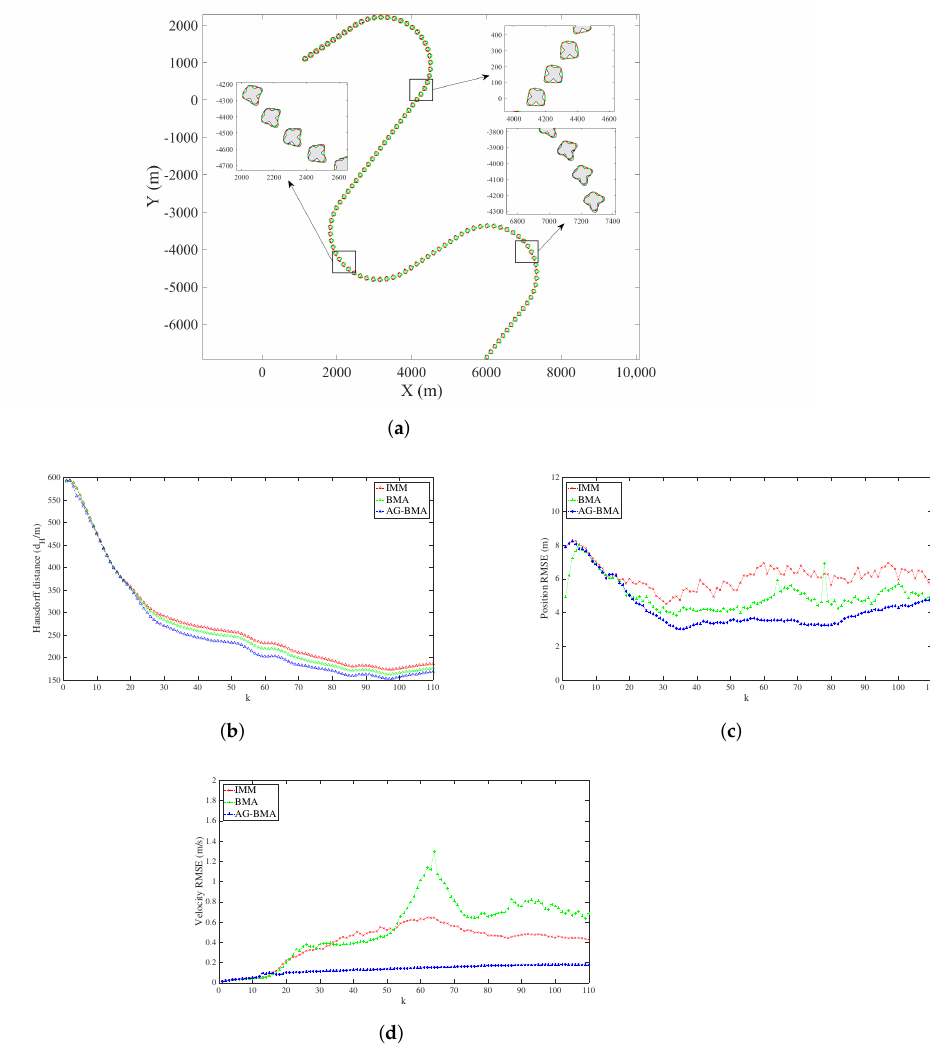
Figure 7. Performance comparison of the three algorithms. ( a ) Trajectory of the target. ( b ) Hausdorff distance. ( c ) RMSE of position. ( d ) RMSE of